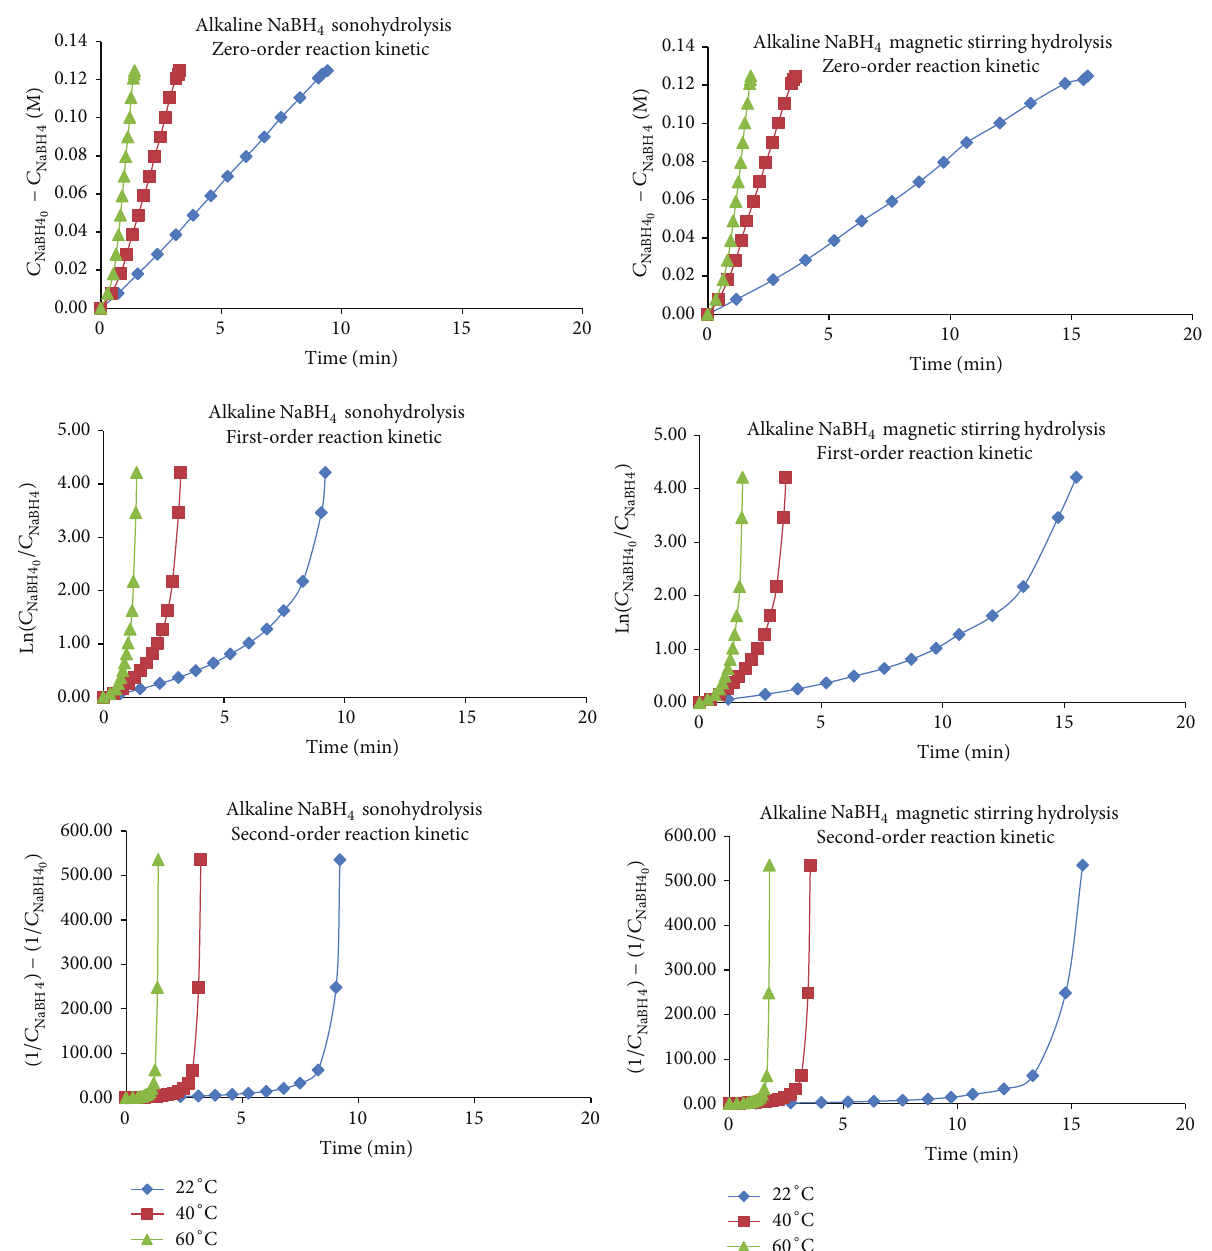
Figure 7: The kinetic investigation: the zero, first, and second reaction kinetic models for sonohydrolysis and magnetic stirring hydrolysis of alkaline (10wt.%) 0.12 M NaBH 4